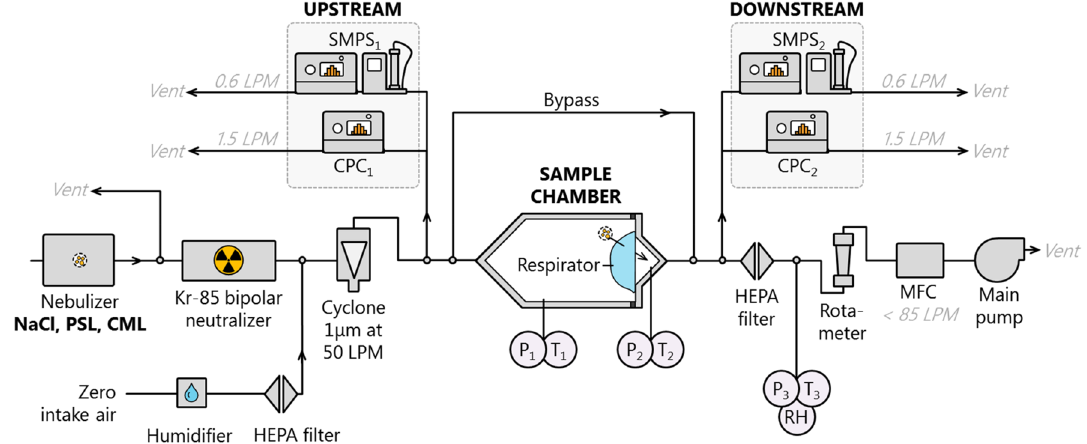
Figure 1. PFEMS configuration setup used for the experiments described in this